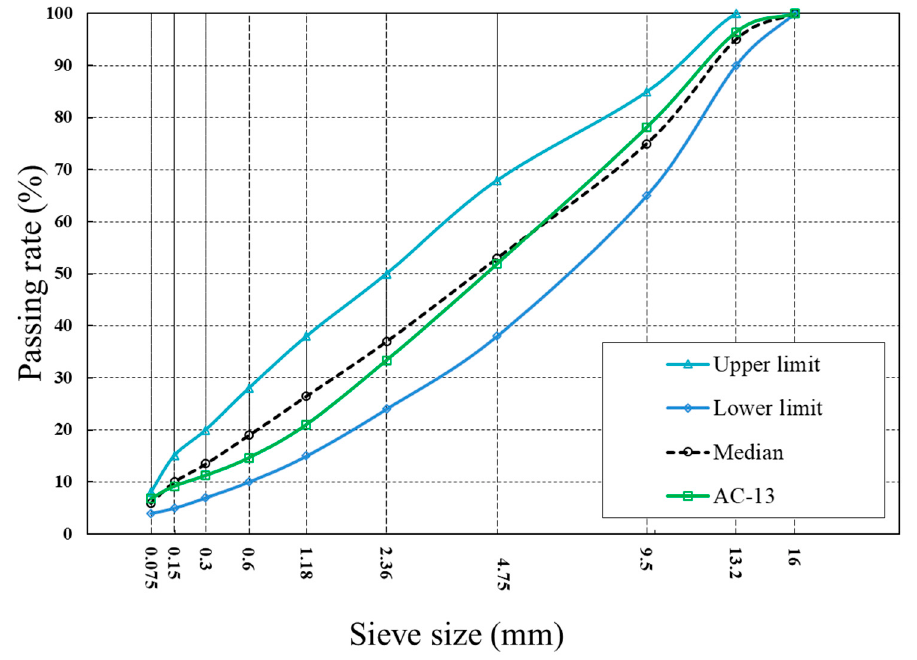
Figure 2. Gradation curve of the asphalt mixture. Reprinted with permission from Ref [36]. 2021,